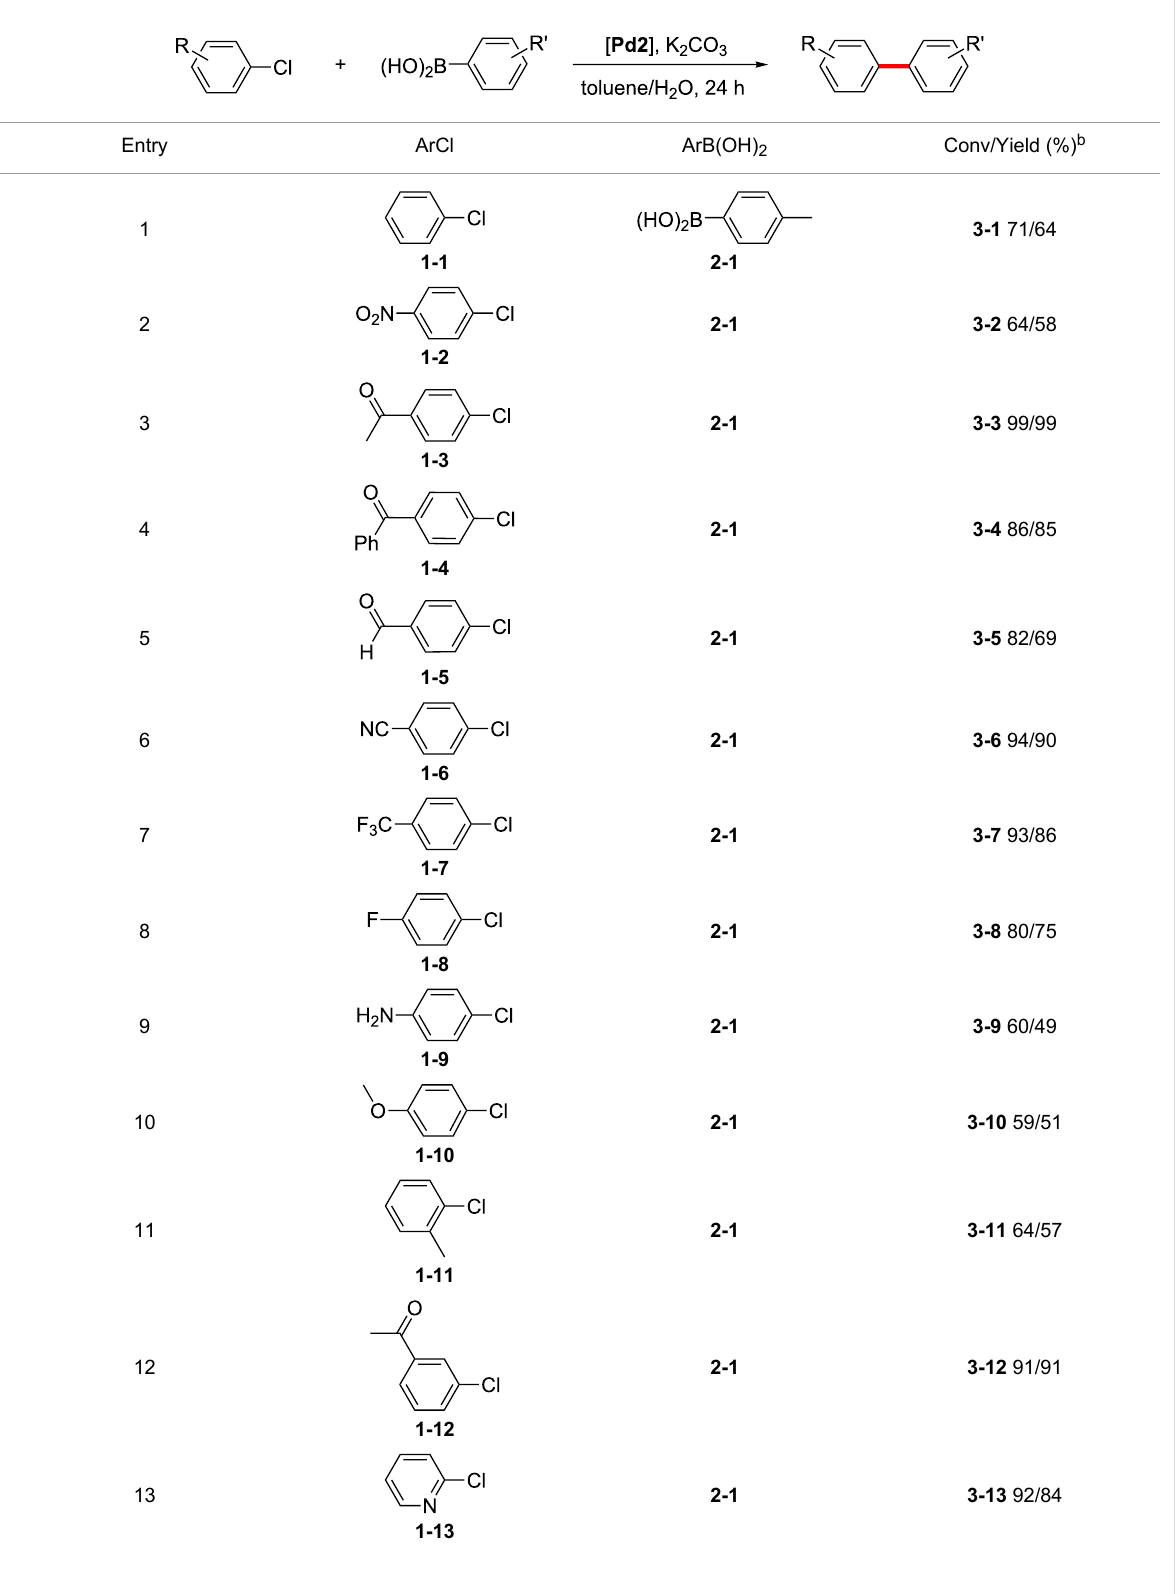
Table 4: Pd-catalyzed coupling between various aryl chlorides and arylboronic acids.